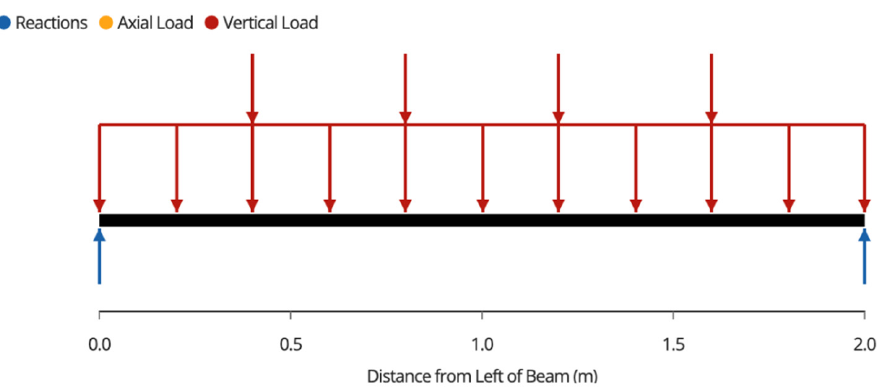
Figure A1. Free body diagram of joists. Note that the two outside joists will have half the tributary area of the inside joists, and thus will carry approximately half of the load.